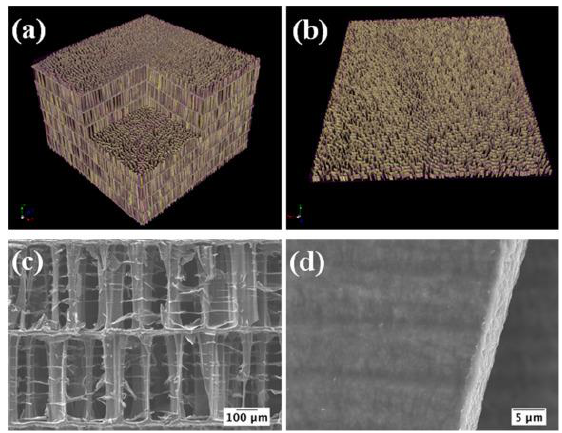
Figure 11. Microstructure of raw CB. ( a , b ) μ-CT images highlighting the interconnectivity and sigmoidal path of the pillars; SEM micrographs ( c ) showing the presence of β-chitin and ( d ) the detail of the pillar wall. Reproduced with permission from [106]. Copyright Elsevier, 2019.